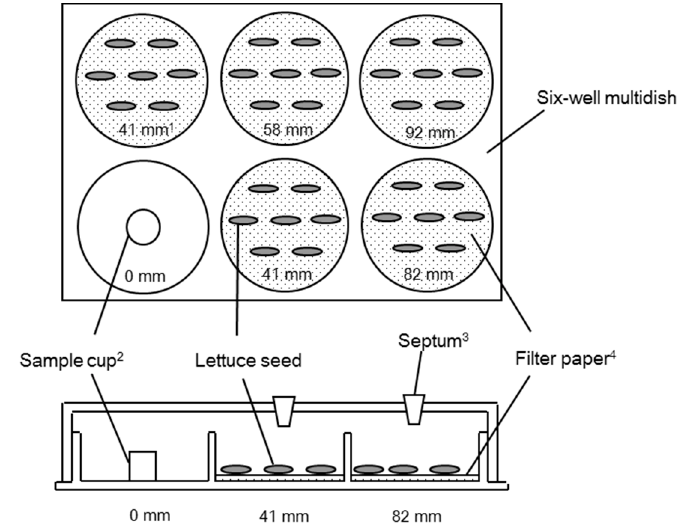
Figure 1. Top and side views of the multi-dish that was used for testing the plant growth inhibitory activities of volatile compounds with the dish pack method. ( 1 ) Distance from the sample or compound; ( 2 ) The source well (or cup in the case of authentic compounds); ( 3 ) Septa were attached for headspace vapour sampling, which was undertaken using a Hamilton gas-tight syringe and analyzed by gas chromatography-mass spectrometry (GC-MS) analysis; ( 4 ) Each filter paper was wetted with 0.7 mL of distilled water.